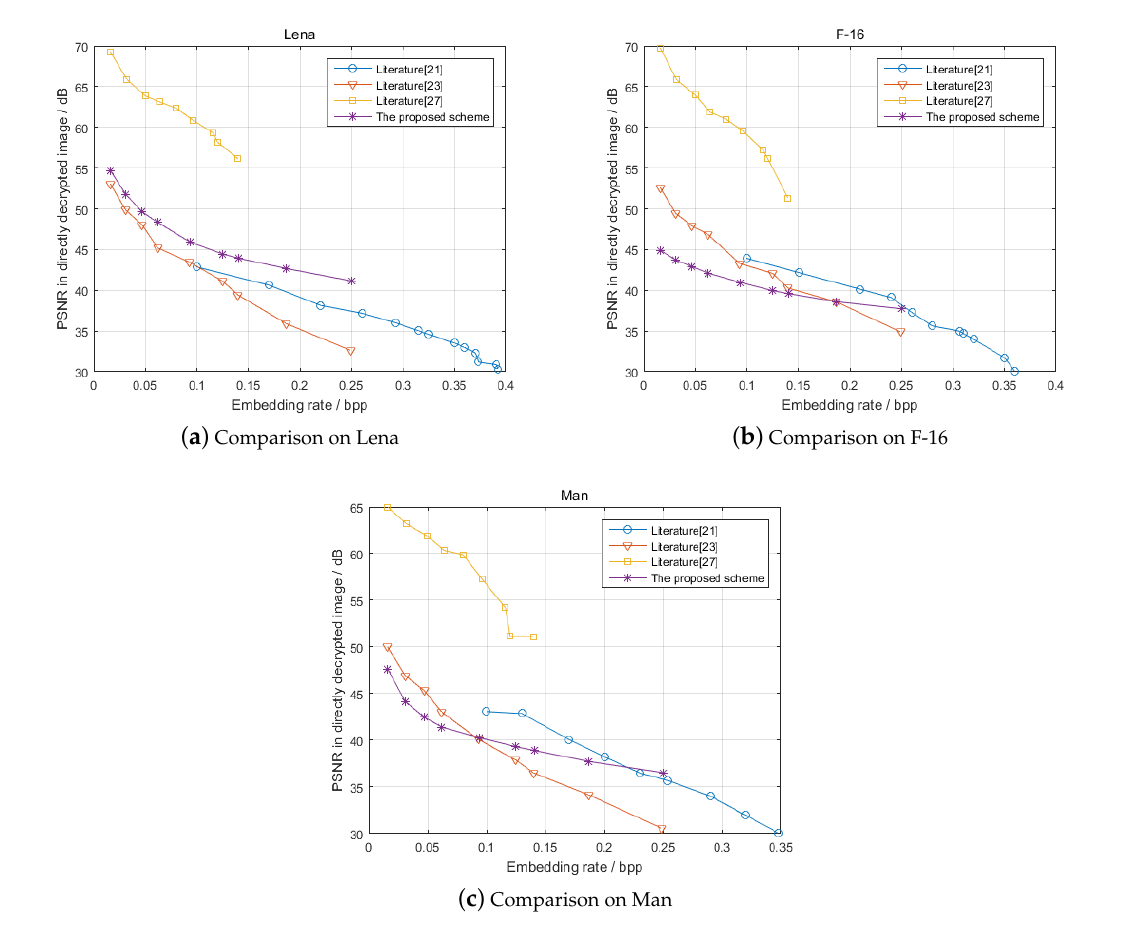
Figure 7. PSNR performance